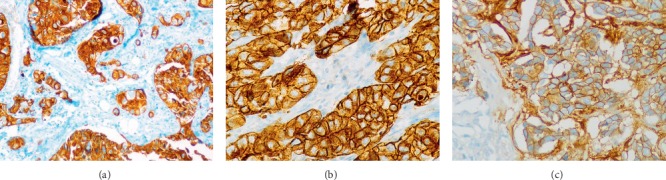
Positive immunohistochemical staining for (a) 34βE12; 40x × 10x, (b) c-Kit; 40x × 10x, and (c) EGFR; 40x × 10x.